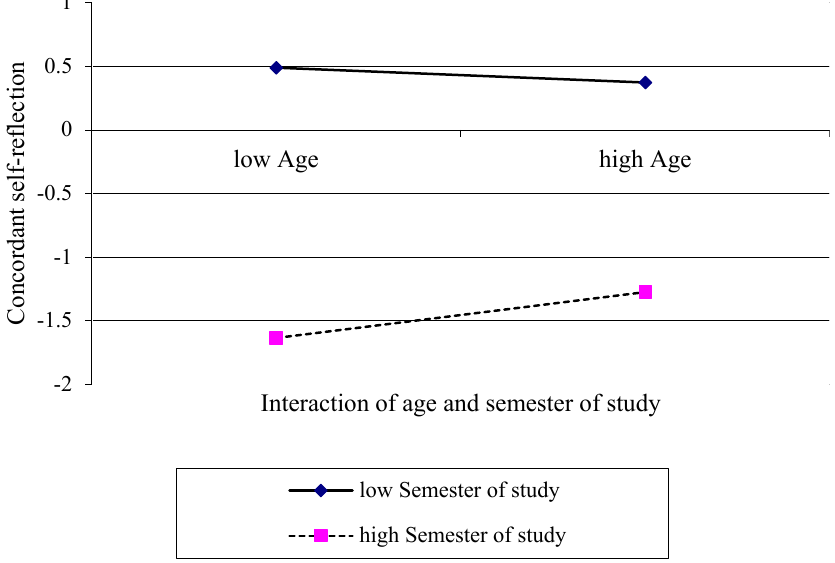
Figure 4. Interaction effect of age and semester of study on the concordant self-reflection in the first aid course concept illustrated as simple slopes.